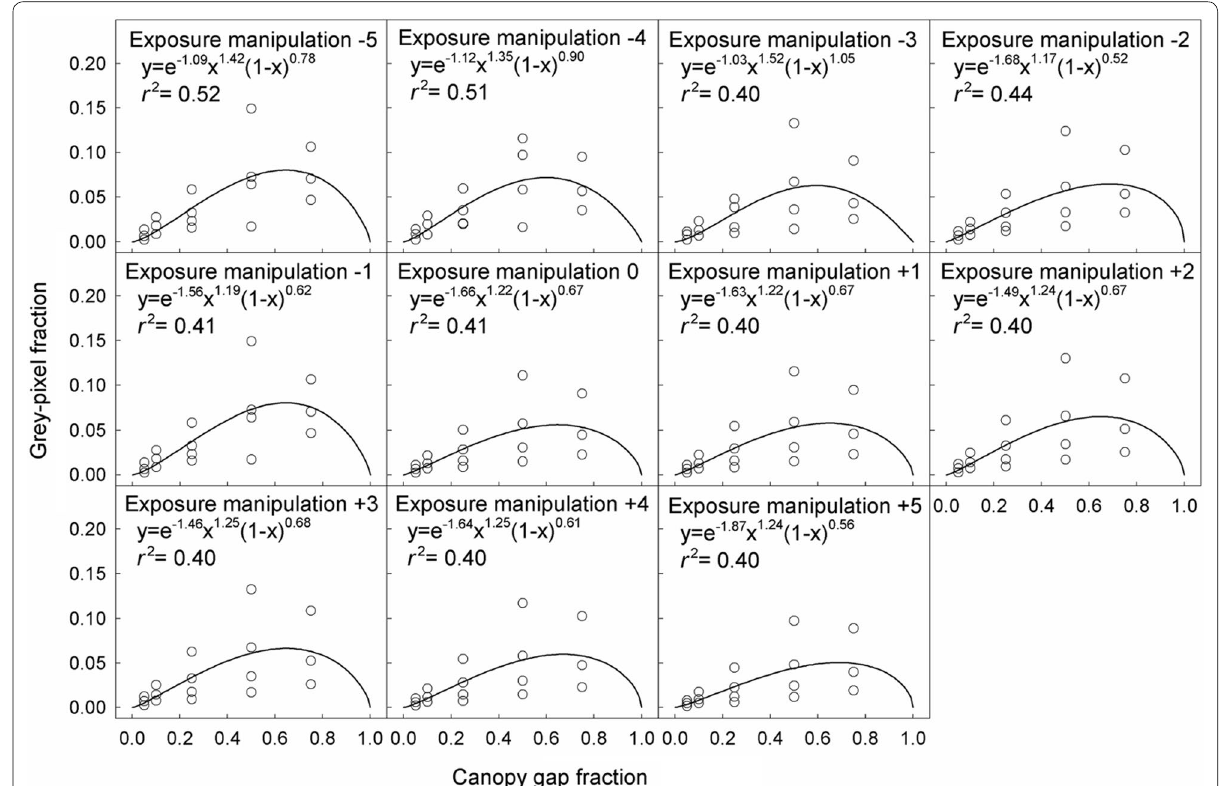
Fig. 2 Relationships between the grey‑pixel fraction and canopy gap fraction in model CHPs. The unit of exposure manipulation is